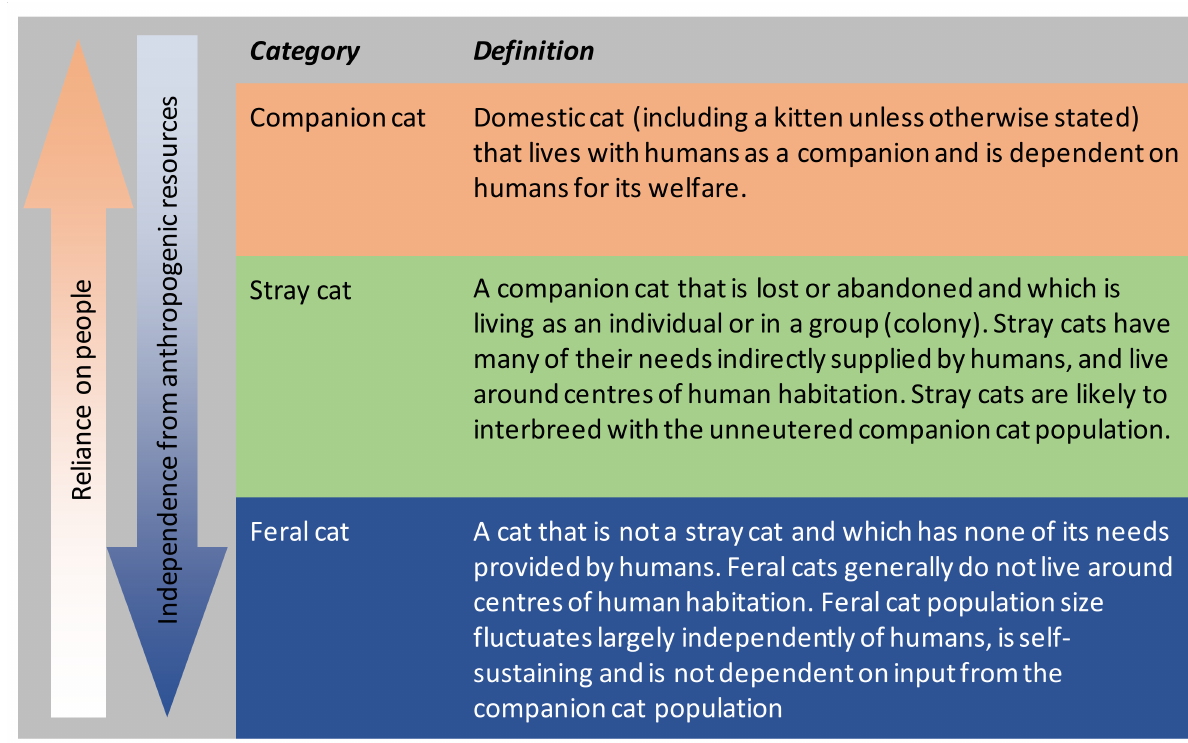
Figure 1. Categories of cats under definitions provided by the New Zealand Government’s Animal Welfare (Companion Cats) Code of Welfare 2018. Sexually entire cats may interbreed across